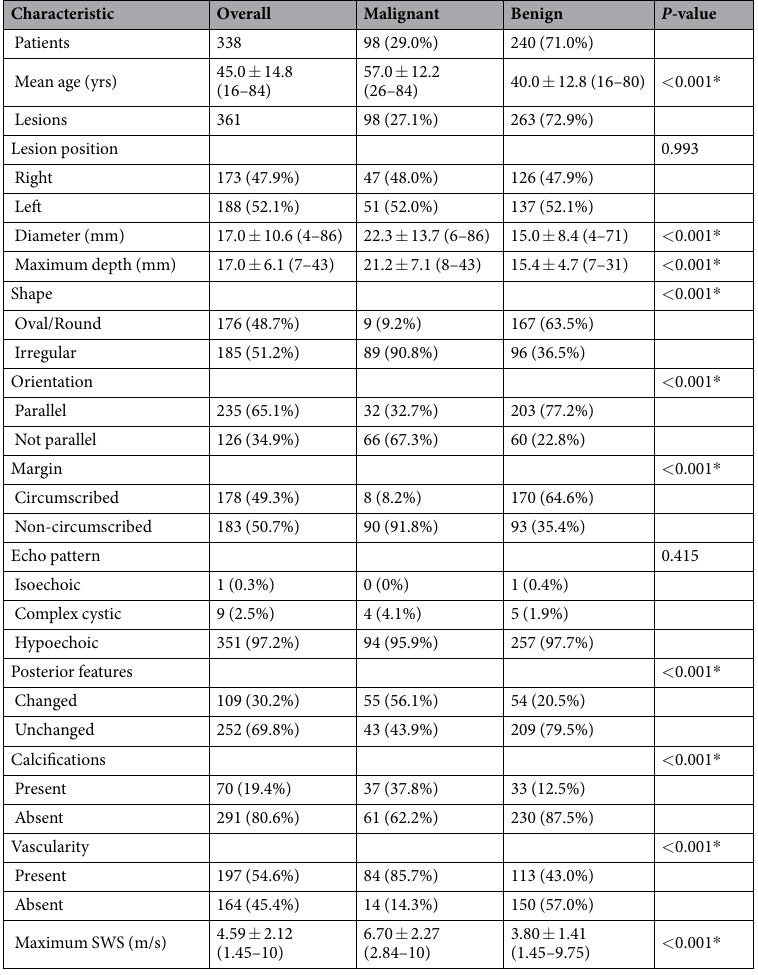
Table 1. The Characteristics of Patients, US and SWS Imaging Features of Breast Lesions. * Indicates a significant difference. US = ultrasound; SWS = shear wave speed; Changed posterior features include enhancement, shadowing and combined